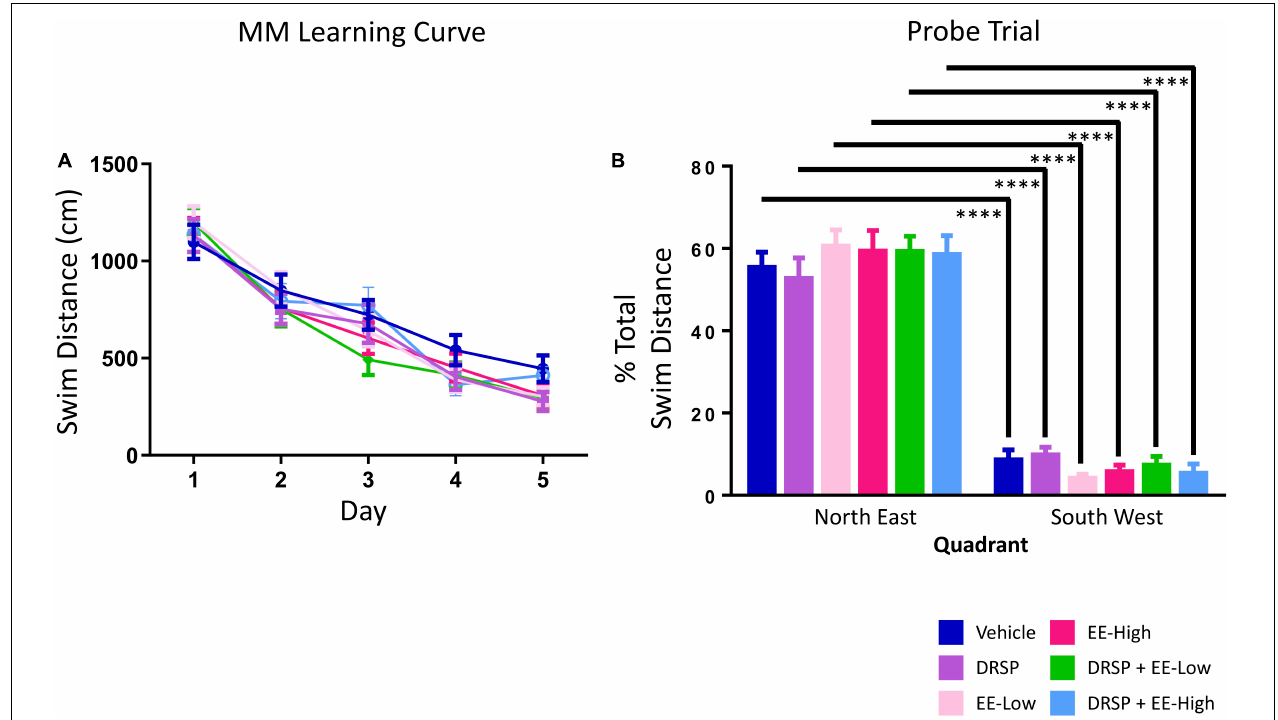
FIGURE 5 | Experiment 2 Morris water maze. (A) There were no Treatment differences across MM Days 1–5. (B) All groups localized to the target quadrant during the probe trial. ∗∗∗∗ p < 0.0001. Vehicle n = 10, DRSP n = 10, EE-Low n = 10, EE-High n = 10, DRSP + EE-Low n = 10, and DRSP + EE-High n =